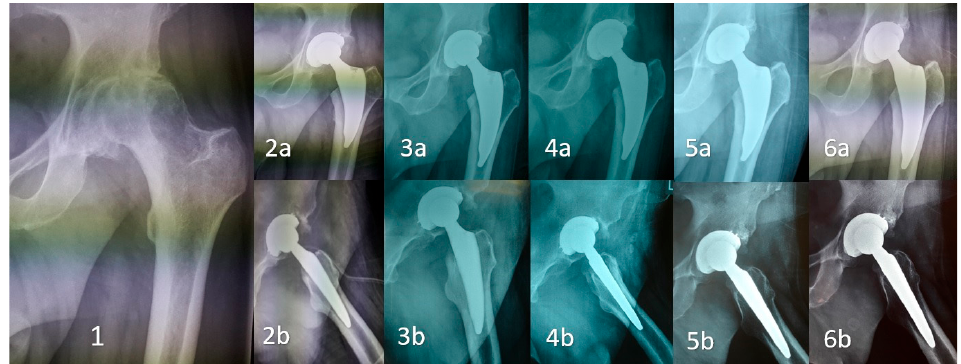
Figure 3. Radiographic evaluation throughout the study. (1) Preoperative anteroposterior (AP) view. (a) AP view, (b) lateral view. (2) postoperative period, (3) One-month follow-up, (4) 3-month